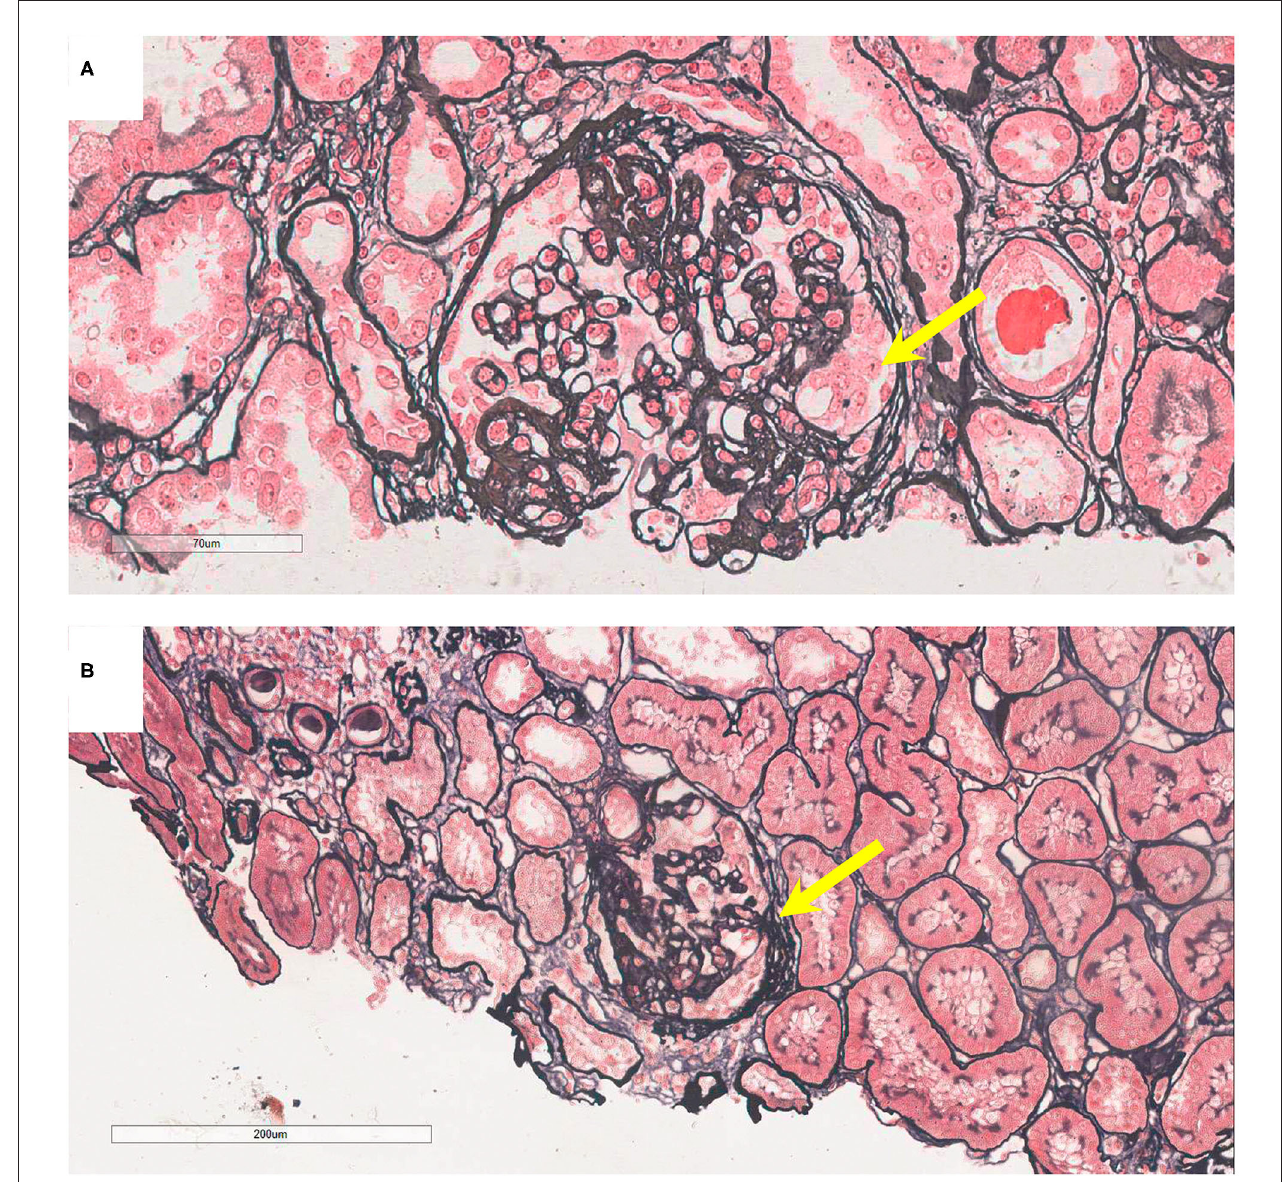
FIGURE 2 | Pathology presentation of patients V-6 and IV-5. (A) Patient V-6: light microscopy showed segmental sclerosis and podocyte hypertrophy (yellow arrow), by periodic acid-silver methenamine (PASM) staining; original magnification: 200X. (B) Patient IV-5: light microscopy showed segmental adhesion and podocyte hypertrophy (yellow arrow; PASM staining,